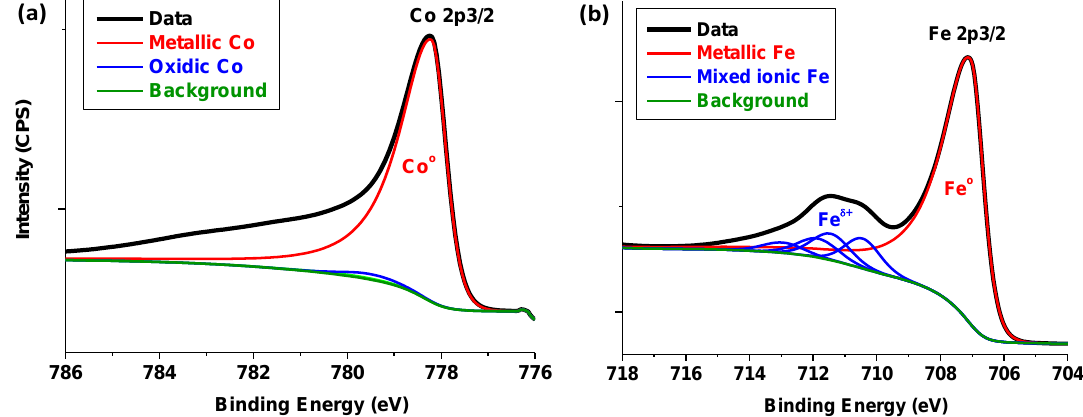
Figure 15. The XPS analysis of the fresh ( a ) Co/C and ( b ) Fe/C catalysts. Reproduced with permission from Reference [48]. Copyright Springer, 2018.